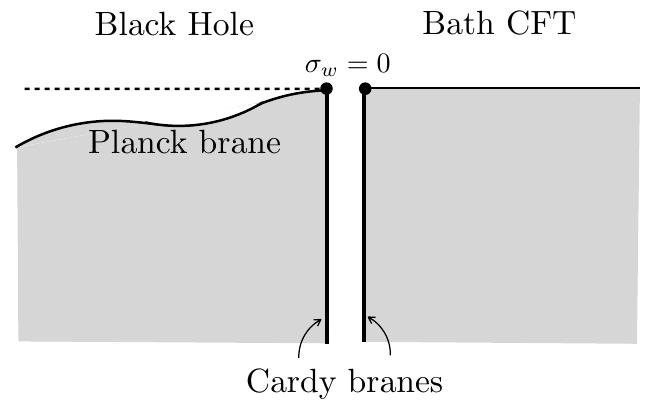
Figure 8 . The decoupled black hole (on the left) and the bath CFT (on the right). We have shown a constant time slice in the 3d geometry. The thick vertical lines are the \Cardy" branes, which are the holographic dual of conformal boundary conditions.